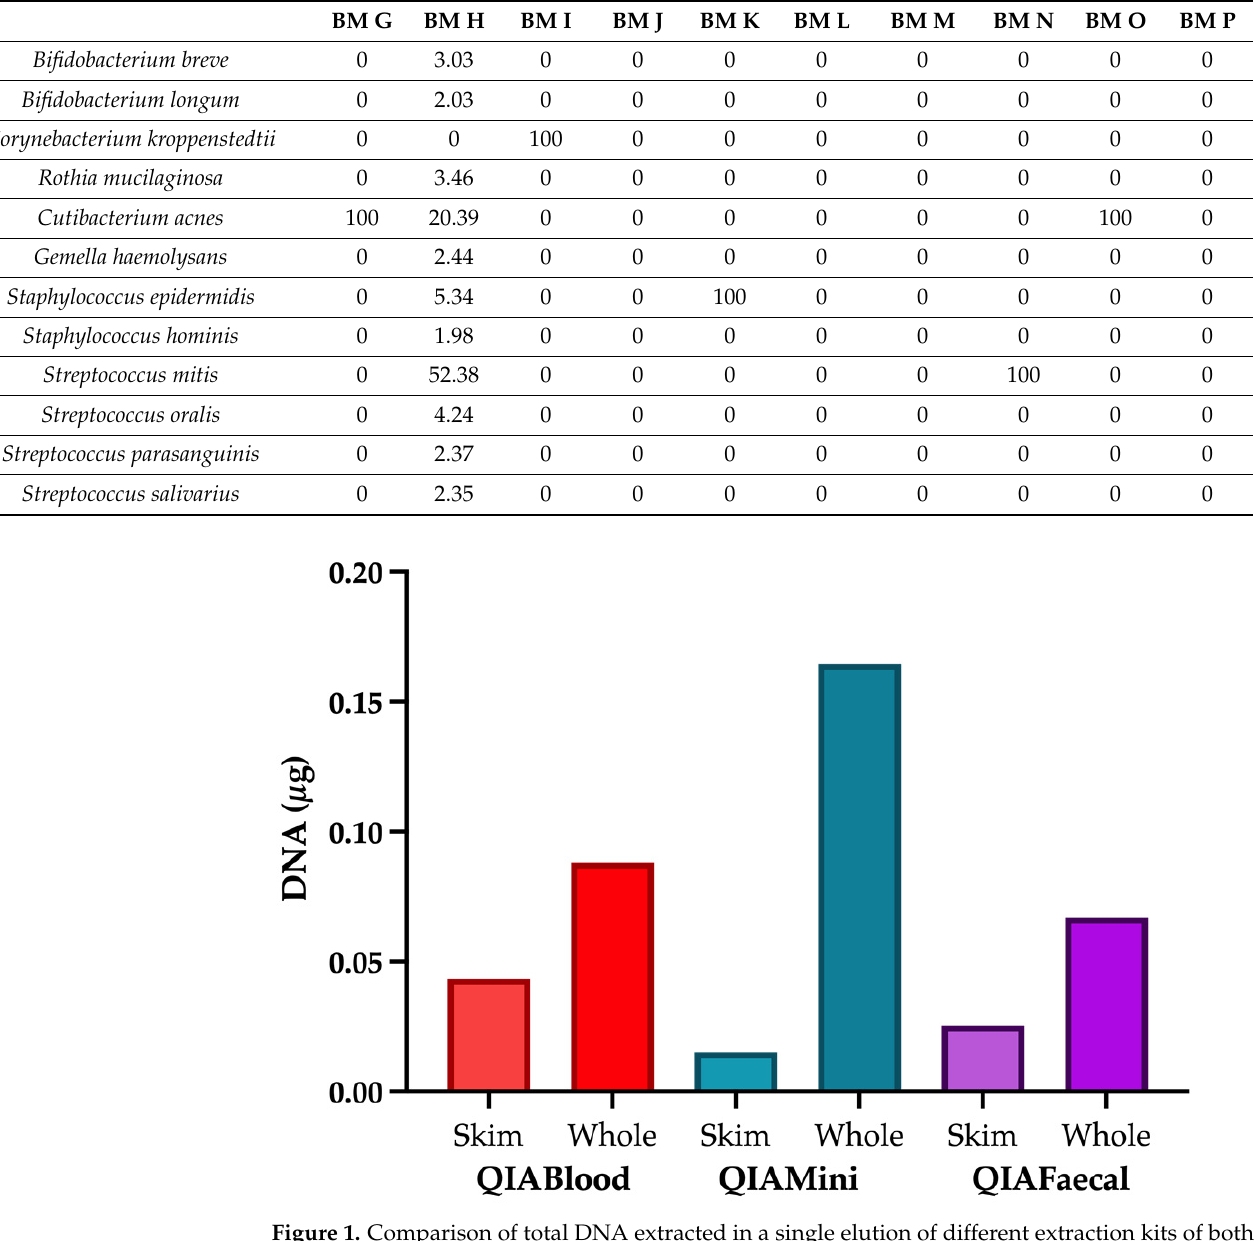
Table 5. Composition of the breastmilk microbiota as sequenced by Facility B and determined by MetaPhlAn3 [39]. Four samples did not produce any identifiable bacterial DNA sequences. Values represent percentage relative abundance.